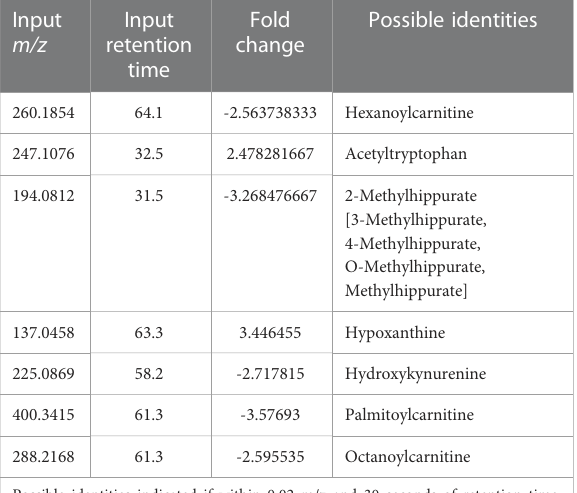
TABLE 2 Mass-to-charge ratio and retention time input values of signi fi cant host metabolites as found by xmsPANDA. Input m/z